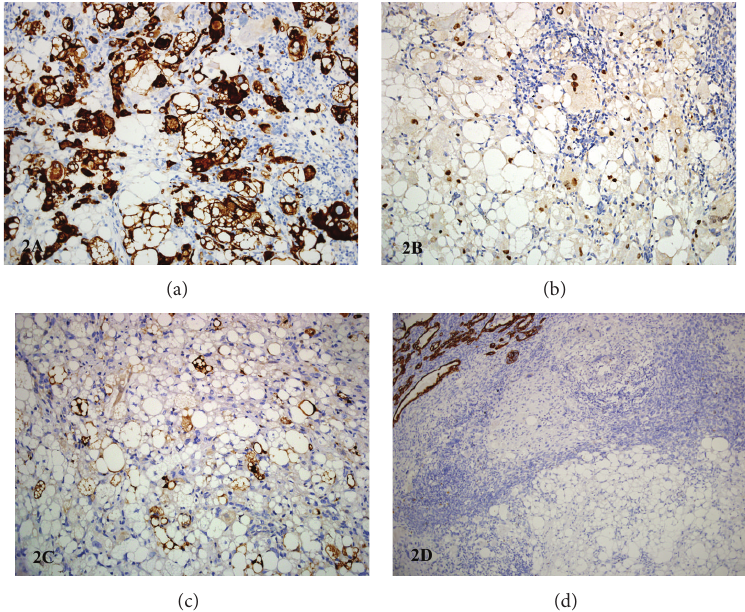
Figure 2: (a) Many of the multivacuolated cells show strong cytoplasmic desmin expression. (b) A smaller number of multivacuolated cells show strong nuclear myogenin expression. (c) Scattered cells are strongly positive for S100 protein. (d) The multivacuolated cells are negative for AE1/AE3, in contrast to the malignant epithelial elements (top left of